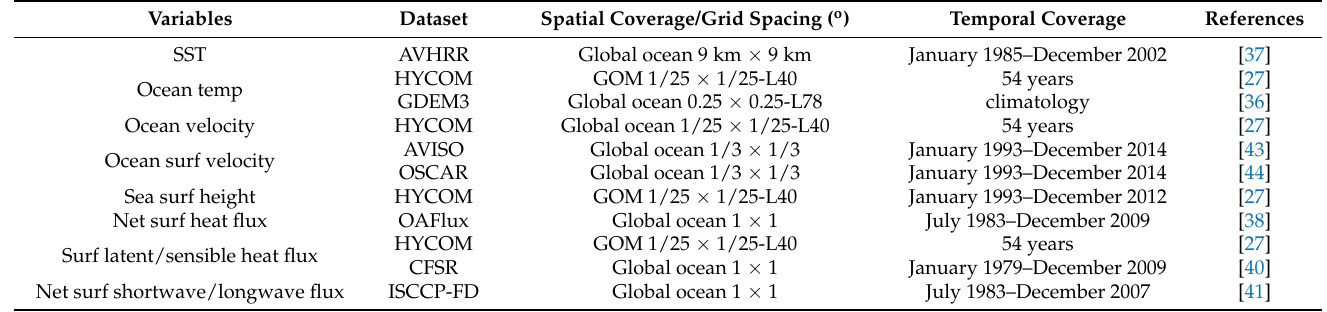
Table 1. List of observational datasets and ocean analysis products used in this study. Variables from AVHRR and OSCAR are at 5-day averages; variables from HYCOM are at daily averages; all other parameters are at monthly averages. More details about datasets are in Section